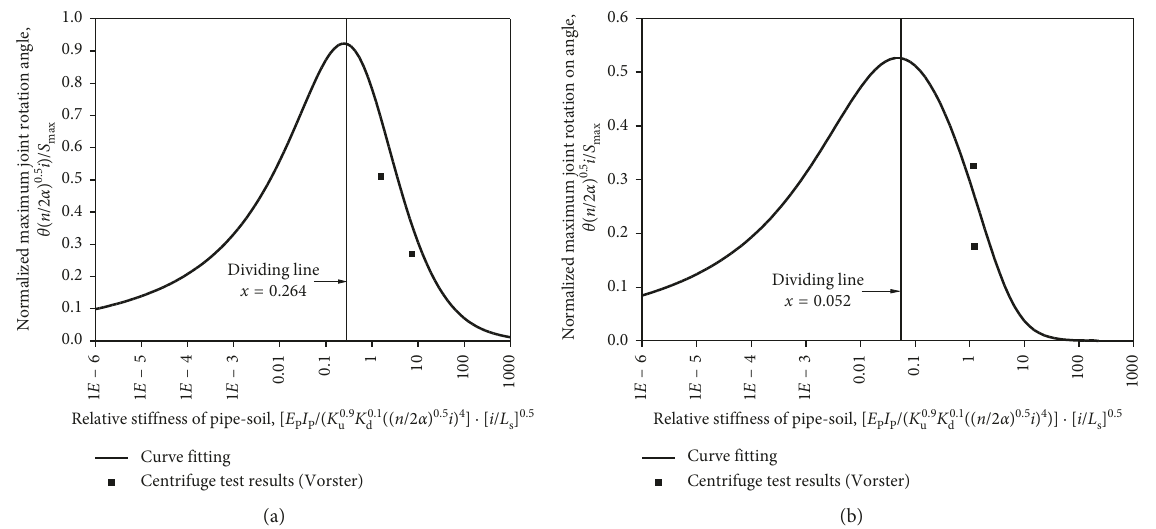
Figure 8: Comparison of computational results and centrifuge test results. (a) The maximum ground settlement is located beneath a joint. (b) The maximum ground settlement is located beneath the centre of a pipe